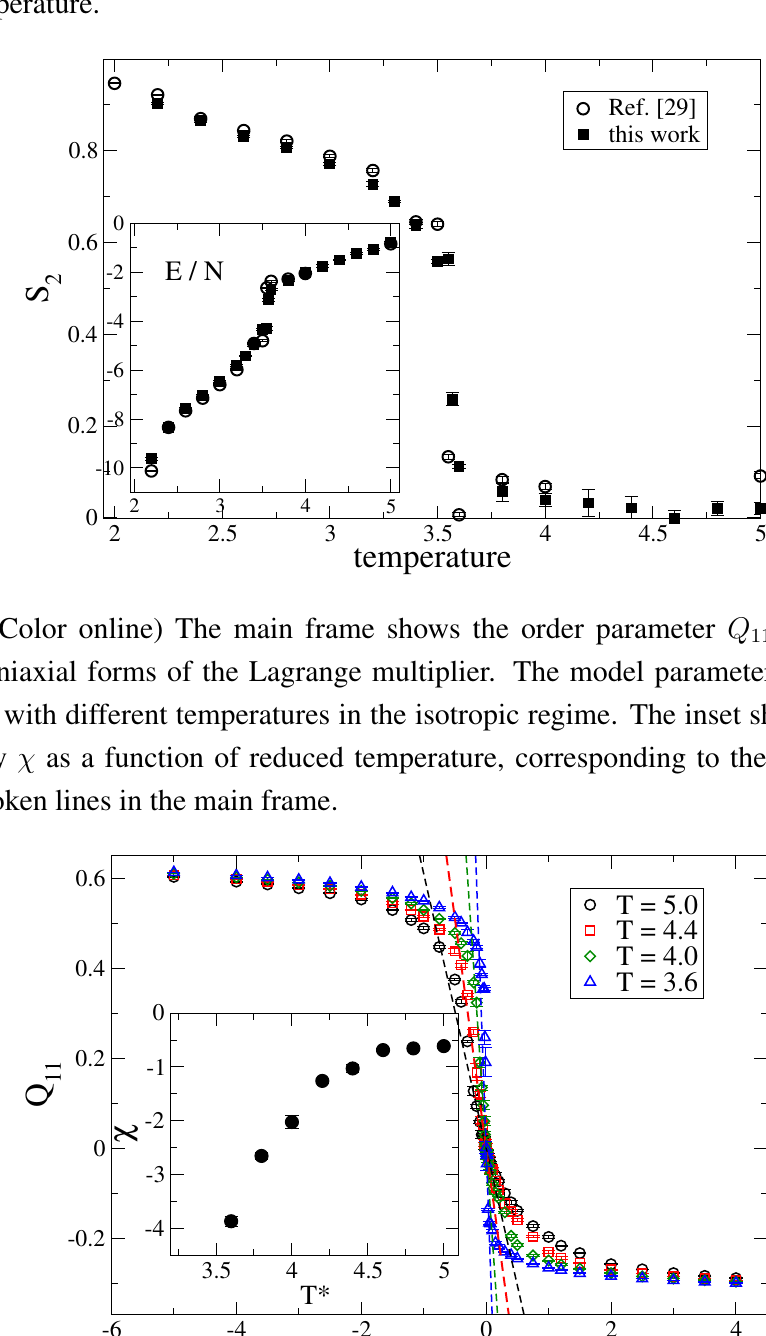
Figure 1. Main frame: The Maier–Saupe orientational order parameter S of reduced temperature T ∗ for the Gay–Berne model [30] from Monte-Carlo simulations of a system of N = 1000 particles. The isotropic–nematic transition is clearly visible. The inset shows the mean potential energy per particle, E/N , also as a function of reduced temperature.